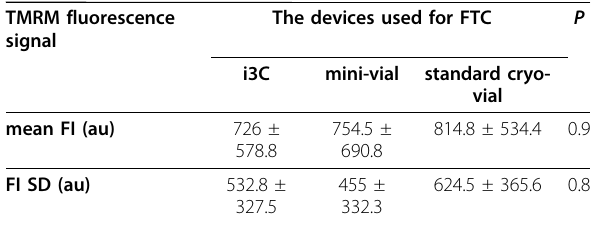
Table 3 Mitochondrial membrane potential of U937 cells after the freezing - thawing cycle TMRM fluorescence The devices used for FTC signal